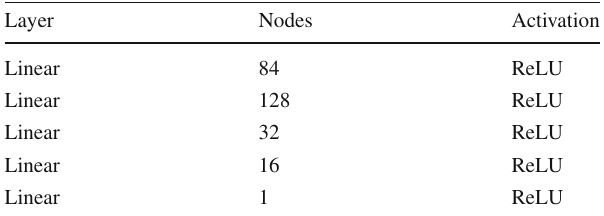
Table 5 Network architecture of the MLP